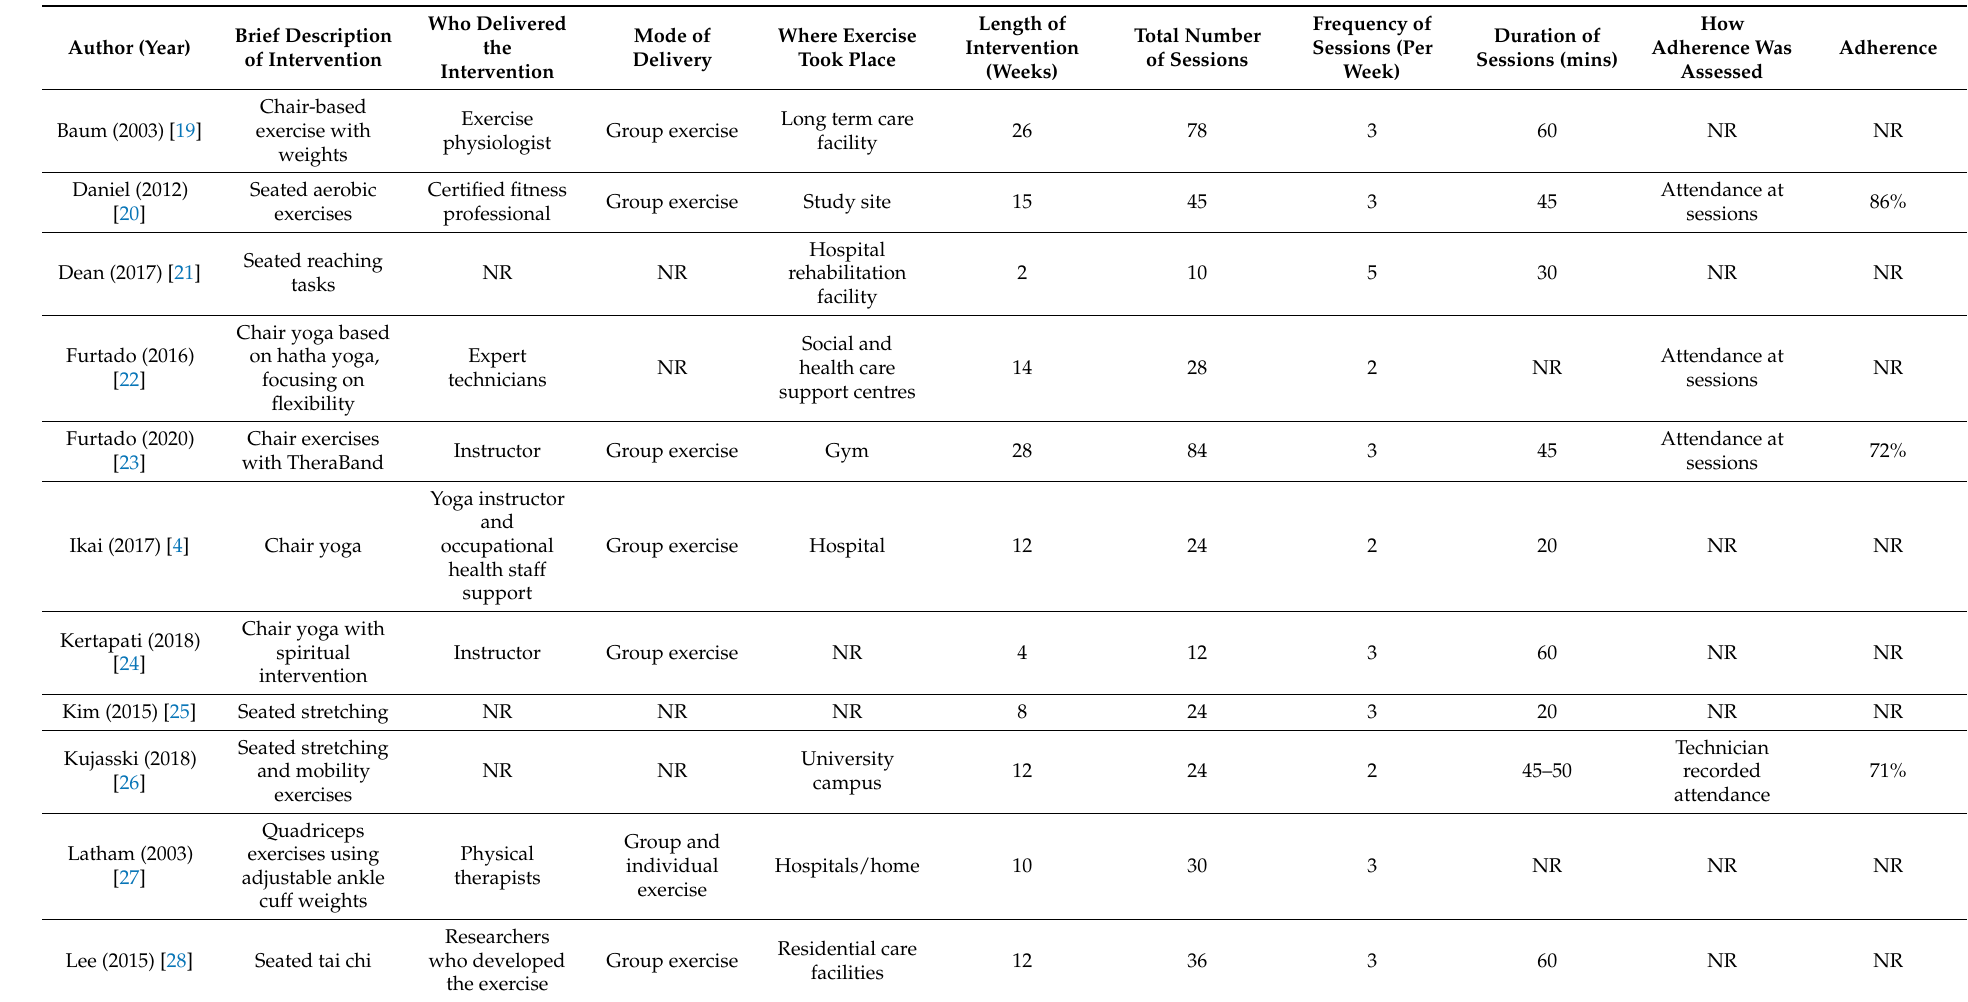
Table 2. Characteristics of included interventions according to Template for Intervention Description and Replication (TiDier)